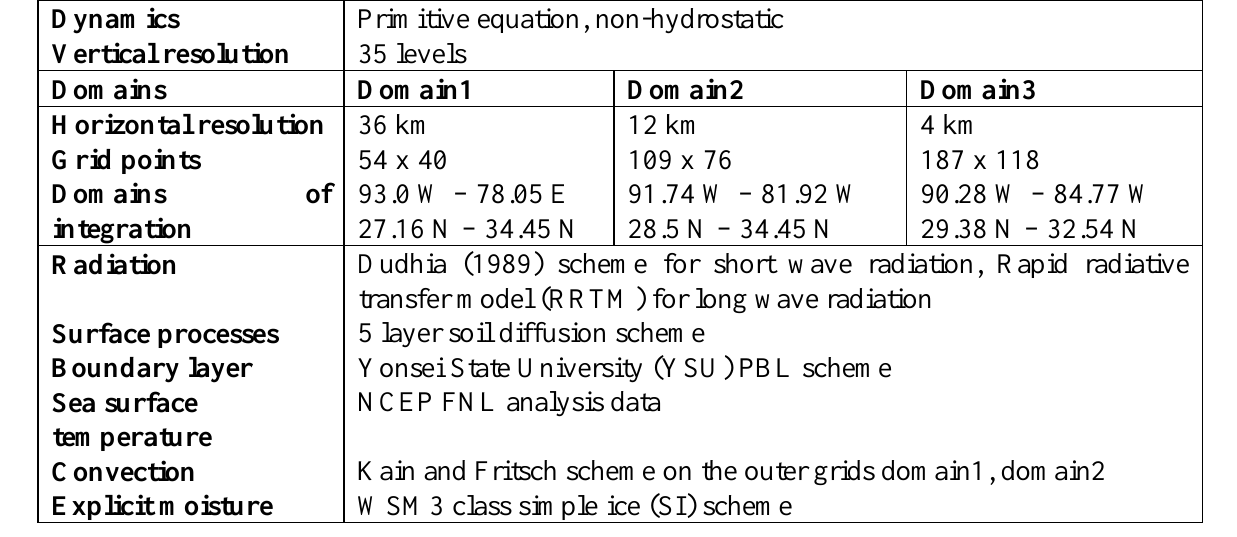
Table 1. Details of the physics and grid configuration used in WRF